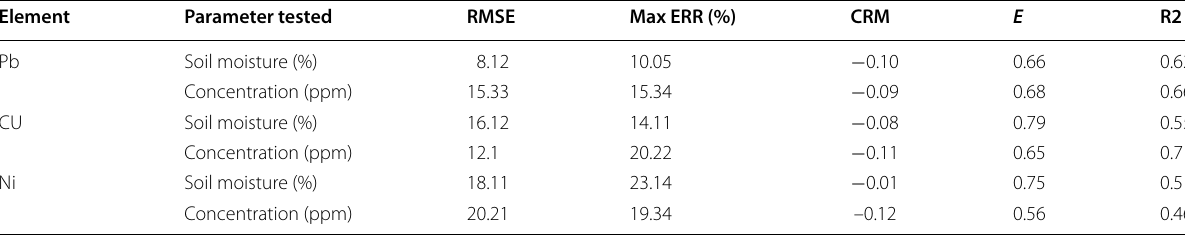
Table 3 Validation of results of the model based on various statistical indicators Element Parameter